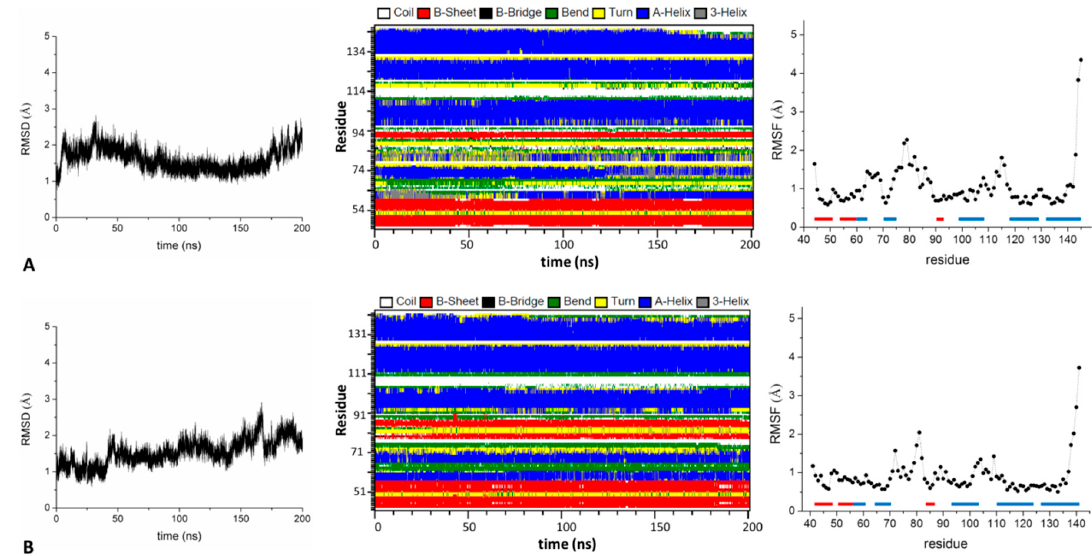
Figure 3. Structure stability of KCTD5 BTB ( A ) and KCTD13 BTB ( B ) monomers throughout the MD simulations: C α -based RMSD values of trajectory structures computed against the starting model, time evolution of the secondary structure content, C α -based RMSF values computed in the equilibrated region of the trajectory (50–200 ns). The protein secondary structure elements are reported as bars ( α -helices in blue and β -strands in red).